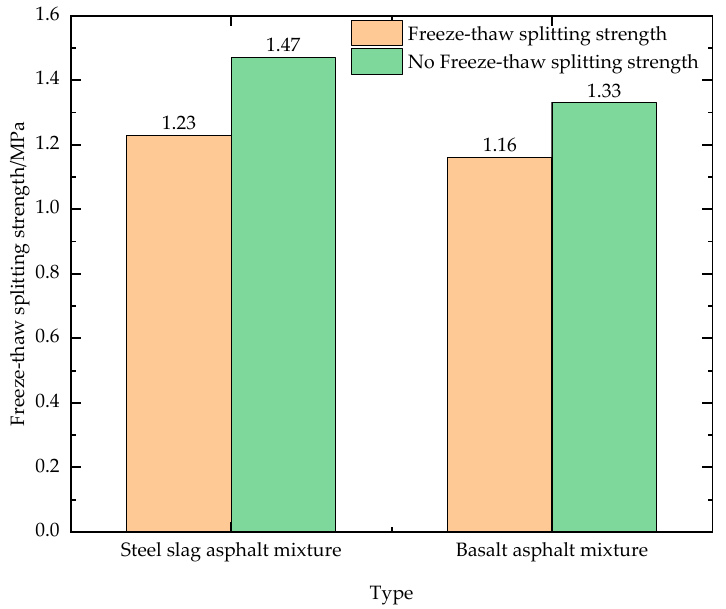
Figure 12. Immersion Marshall stability of two types of asphalt mixture.